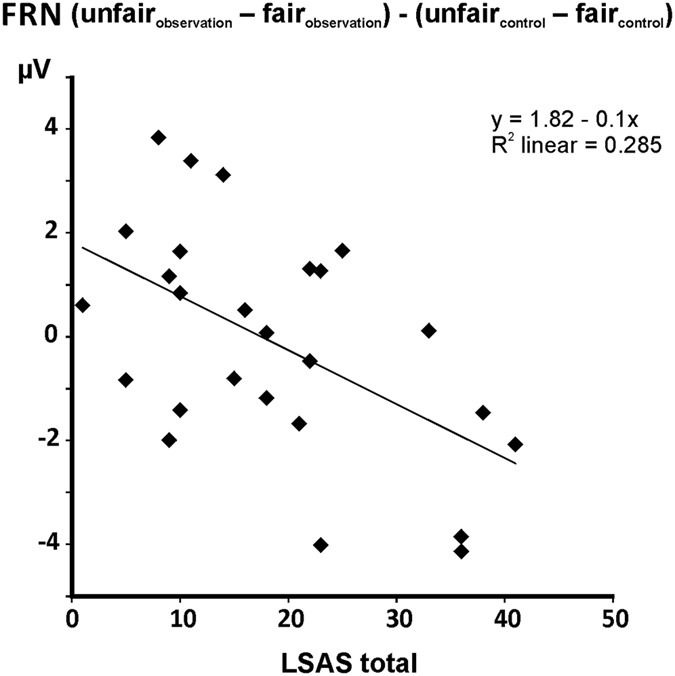
Scatter plots with regression lines illustrating the relationship between LSAS scores and FRN magnitude differences [(unfairobservation − fairobservation) − (unfaircontrol − faircontrol)].